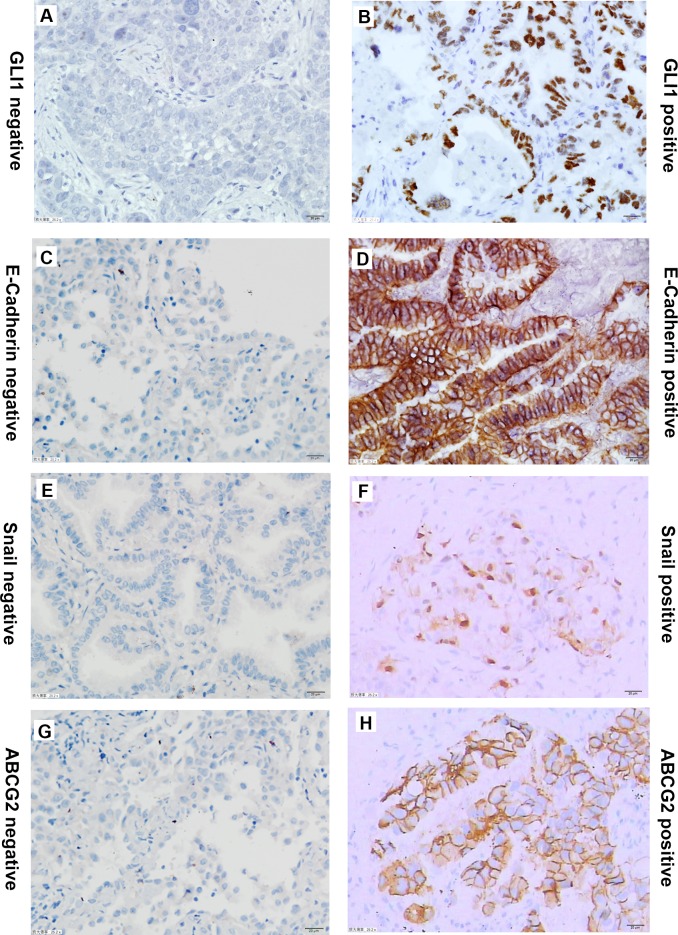
Representative immunostaining of GLI1, ABCG2, E-Cadherin and Snail in NSCLC tissues.(A) and (B), negative control and positive GLI1 expression in NSCLC tissues. (C) and (D), negative control and positive E-Cadherin expression in NSCLC tissues. (E) and (F), negative control and positive Snail expression in NSCLC tissues.(G) and (H), negative and positive ABCG2 expression in NSCLC tissues.